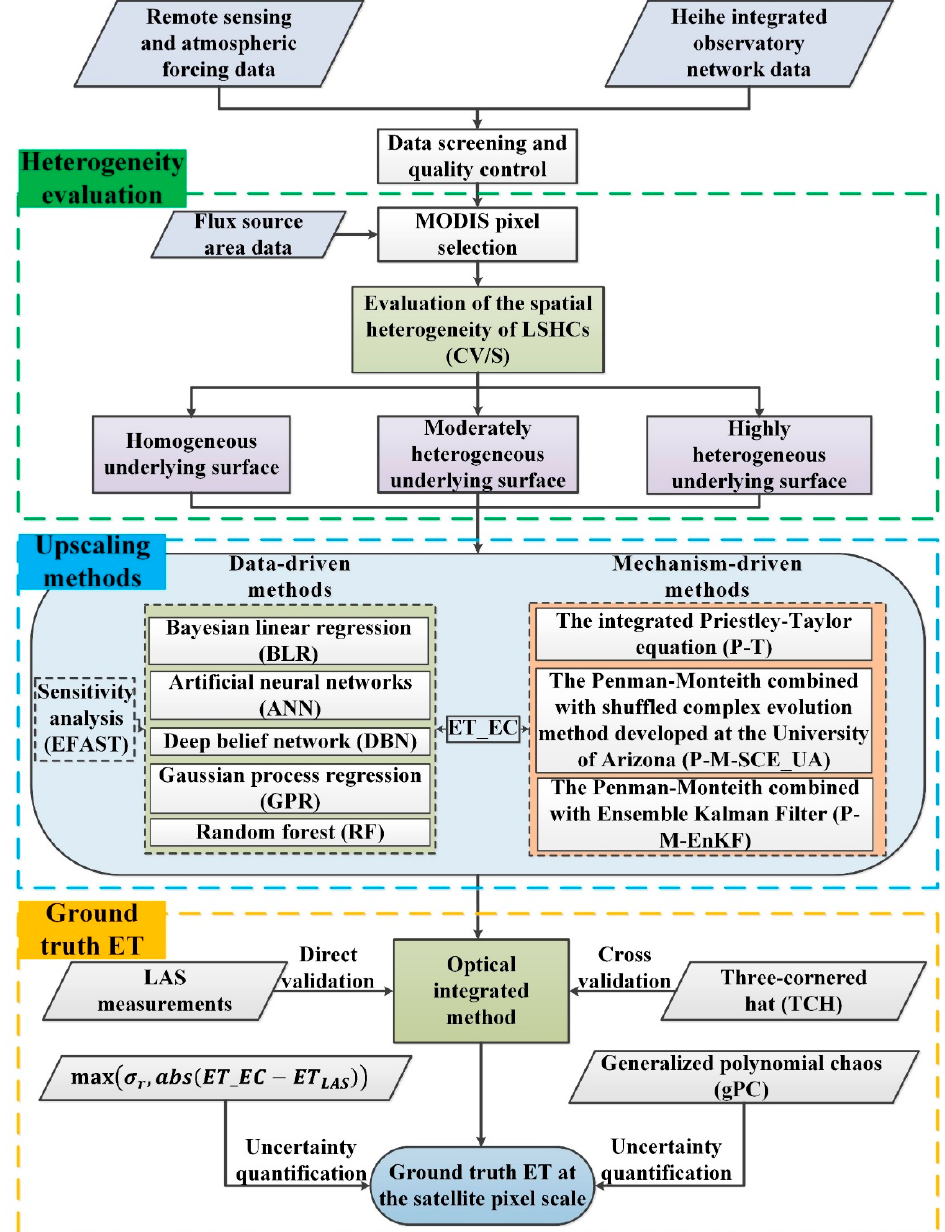
Figure 2. The framework of acquiring the ground truth ET at the satellite pixel scale.